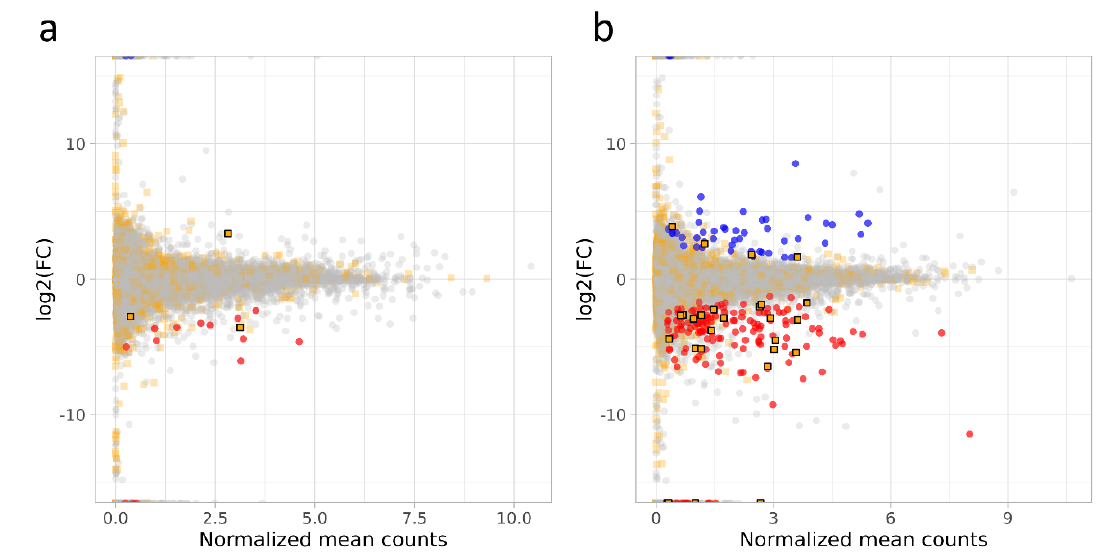
Figure 3. MA plot of ff-FGR ( a ) and mf-FGR ( b ) samples. Each point represents a locus (XLOC), gray dots are genes and orange rectangles represent both predicted and known lncRNAs. Blue dots are upregulated DEGs, red dots are downregulated DEGs and orange rectangles with black frames are DELs.